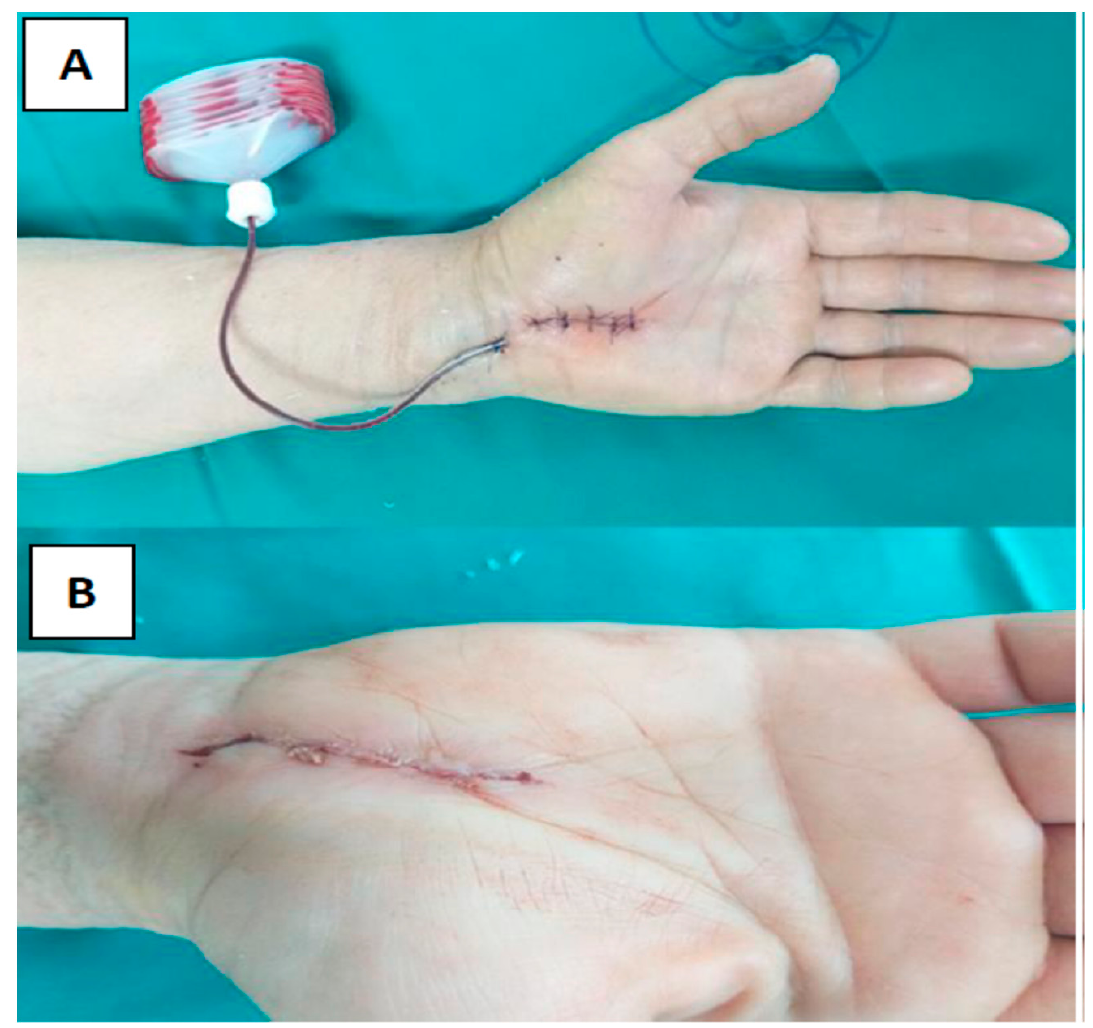
Figure 2. Photographs of a patient demonstrating suture wound closure ( A ) and a patient demon- strating wound closure with Glubran Tiss ® ( B ).